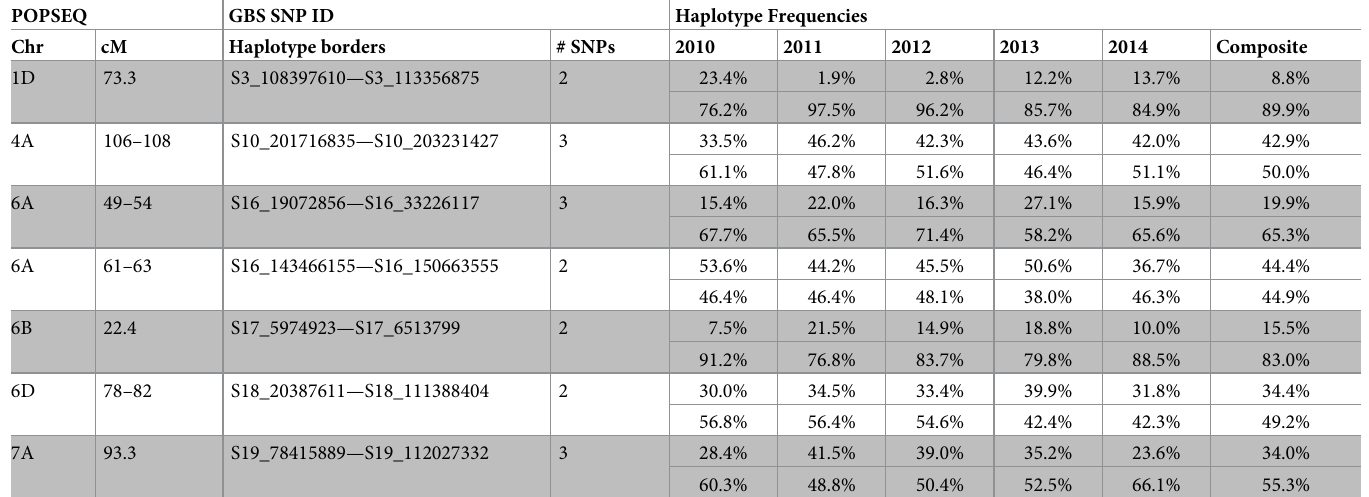
Table 1. Haplotype frequencies.